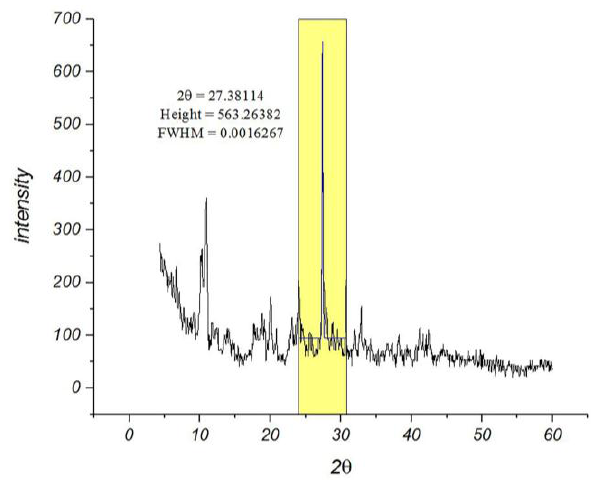
Figure 2. The XRD pattern of nano-MIL-100. The data for the main peak is provided.